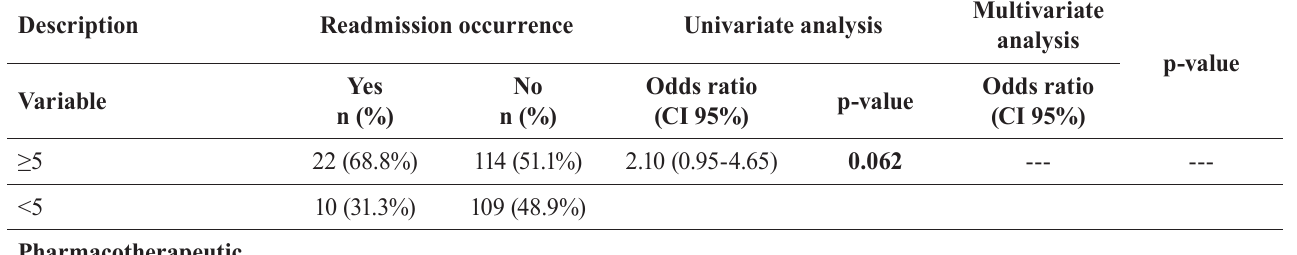
TABLE II – Univariate and multivariate analysis of the factors associated with the occurrence of readmission of older adults within 30